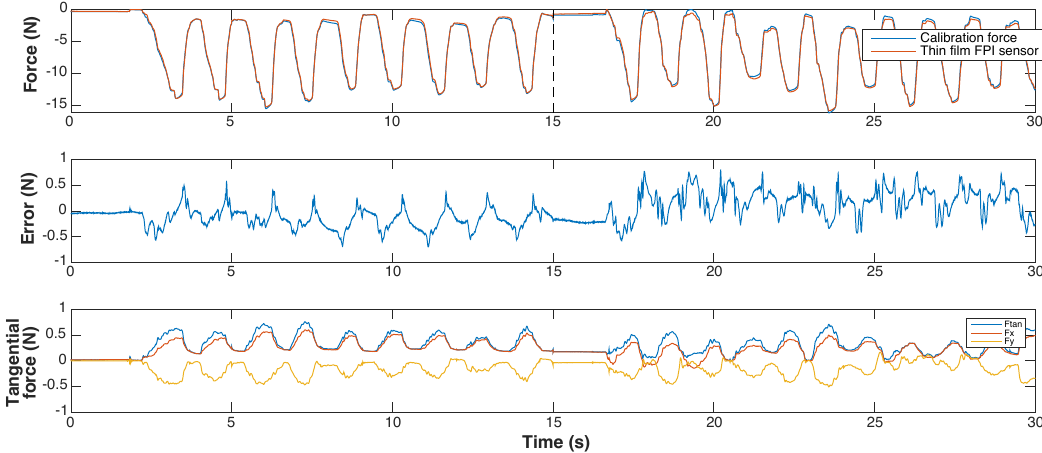
Figure 16. Calibration results of dynamic calibration of a proof-of-concept of the thin-film concept at room temperature, shown as function of time. The graphs show, from top to bottom: (1) the calibration force and the force measured with the proof-of-concept, calculated using the interpolation function shown in Figure 15; (2) the measurement error of the proof-of-concept; (3) the transverse force on the needle tip, shown as the resultant transverse force (Ftan) and its two orthogonal components (Fx and Fy). The dotted lines in the top graph (1) indicate the 15 s long fragments of which the dataset obtained during dynamic calibration is